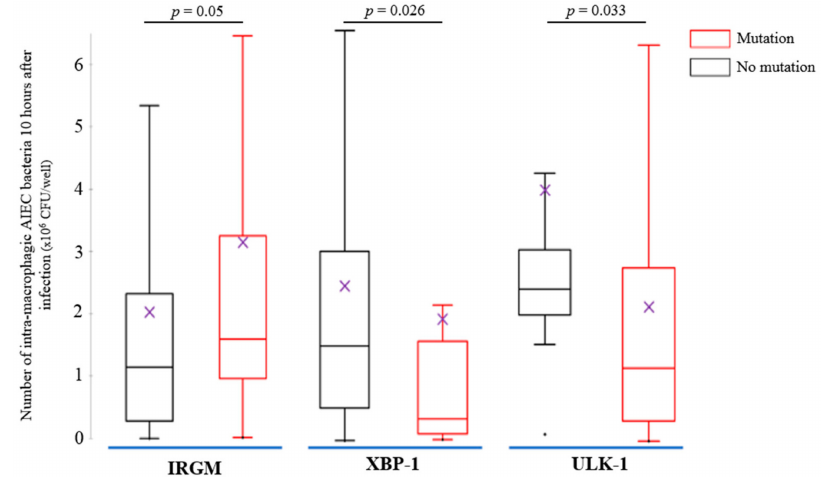
Figure 2. Results of the multivariate analysis of adherent and invasive E. coli survival within monocytes-derived macrophages from 95 Crohn’s disease (CD) patients according to the presence of the CD-associated polymorphisms IRGM ( n = 27 patients, 28.4%), XBP1 ( n = 13 patients, 13.7%) and ULK1 ( n = 82 patients, 86.3%). The comparisons were performed using the Mann-Whitney test and the figure was presented with Tukey grouping. (Means are represented as purple crosses and median as horizontal lines; for IRGM, “no mutation” means patients who are not carrying CD-associated polymorphism IRGM; for XBP-1, “no mutation” means patients who are not carrying CD-associated polymorphism XBP-1; for ULK-1, “no mutation” means patients who are not carrying CD-associated polymorphism